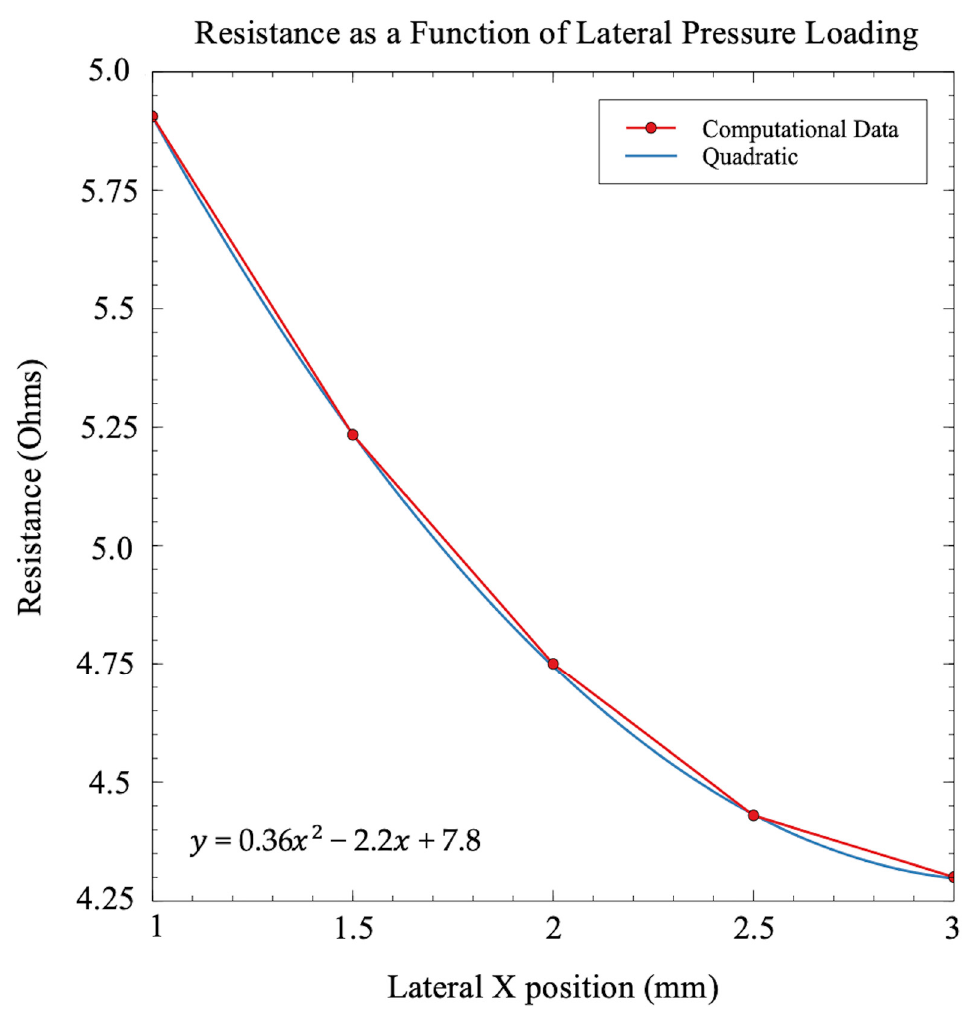
Figure 10. The resistance as a function of lateral pressure loading was determined. A lateral compression defined by Figure 9 was simulated at a constant 0.4 N force. A quadratic function was fit to the to the data points, with the equation of the line displayed.